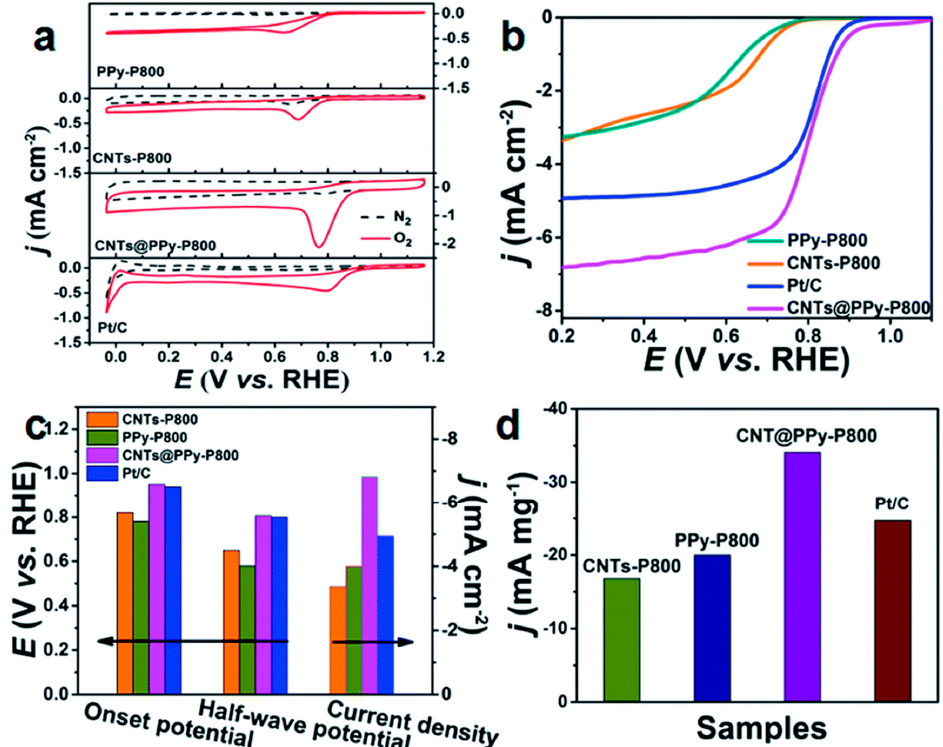
Figure 2. ( a ) CV curves of PPy ‐ P800, CNTs ‐ P800, CNTs@PPy ‐ P800, and Pt/C in N 2 and O 2 ‐ saturated solution, respectively. ( b ) LSV curves of PPy ‐ P800, CNTs ‐ P800, CNTs@PPy ‐ P800, and Pt/C catalyst in O 2 ‐ saturated 0.1 M KOH solution at a sweep rate of 10 mV s − 1 and an electrode rotation speed of